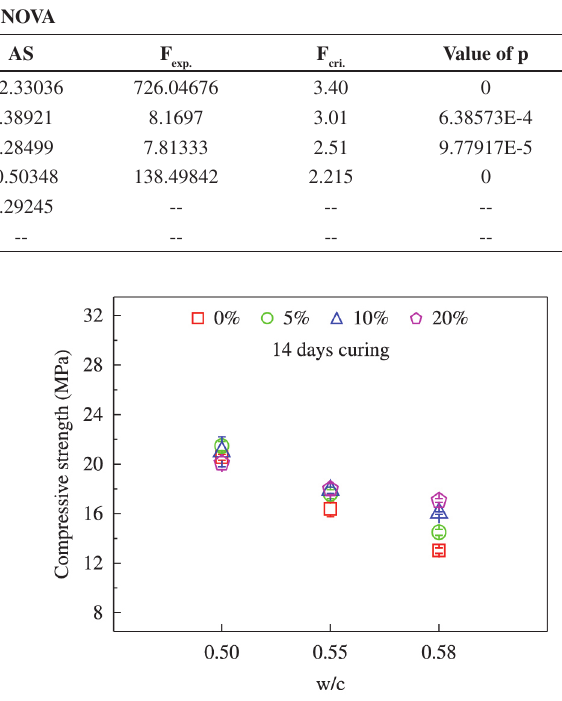
Figure 6. Compressive strength as a function of the w/c ratio after 14 days of